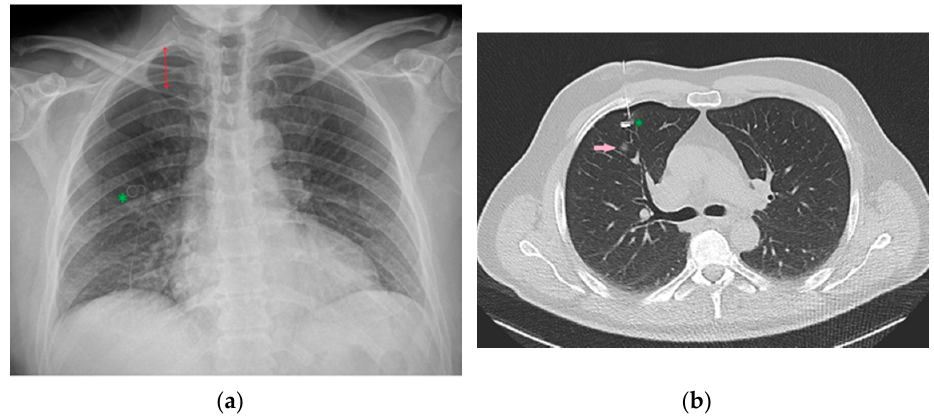
Figure 34. Image of a CXR ( a ) obtained after CT-guided positioning ( b ) of a microcoil (green asterisk) into the lung parenchyma as a landmark to more easily recognize and resect the adjacent nodule (pink arrow) intraoperatively. Development of pneumothorax as a complication following this procedure is not uncommon [36], as it is possible to appreciate this in the reported CXR (red double arrow).